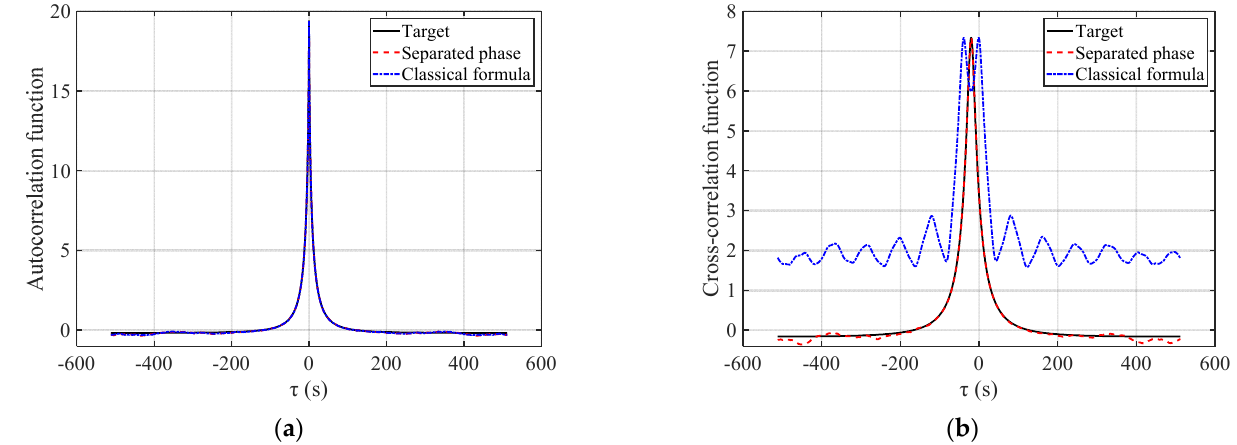
Figure 6. Estimated correlation functions by ergodic stationary wind fluctuation samples: ( a ) R ( τ ) ; ( b ) R ( τ ) 21,21 1,21